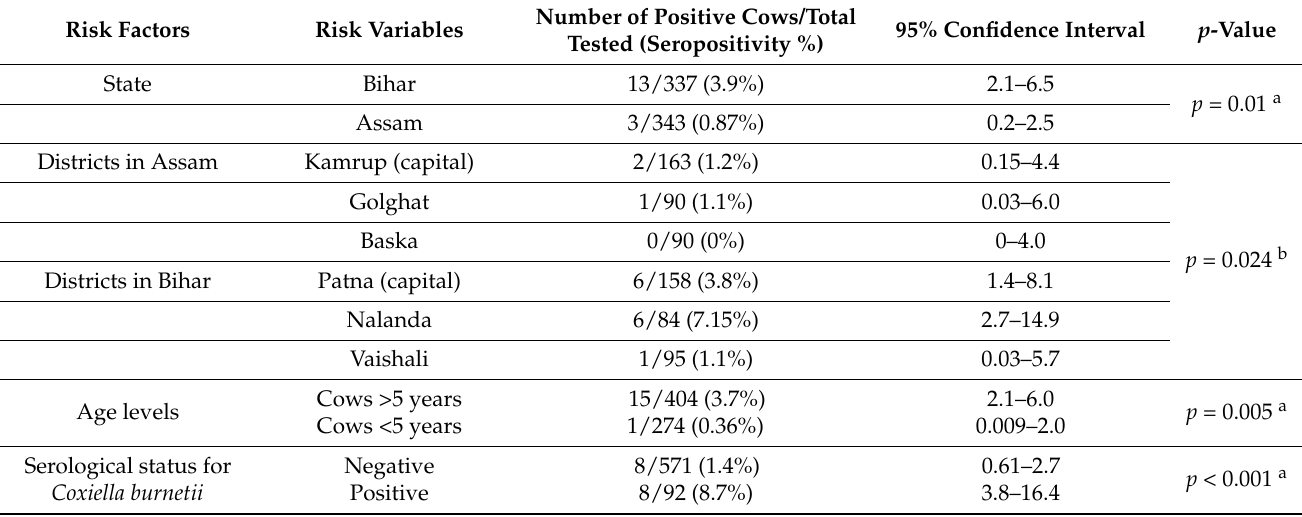
Table 2. Univariable analysis for risk factors associated with L. serovar Hardjo cow seropositivity. Risk